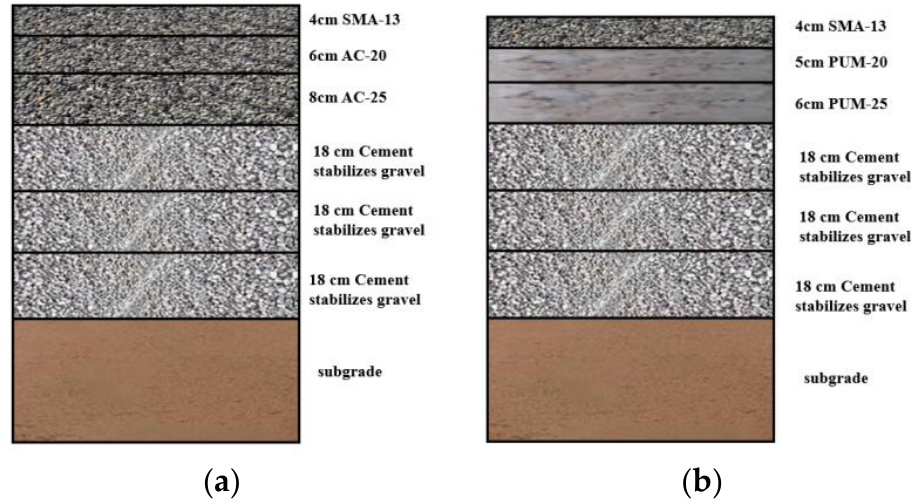
Figure 15. Schematic diagram of the two pavement structures. ( a ) Typical pavement structure. ( b ) Composite pavement structure.